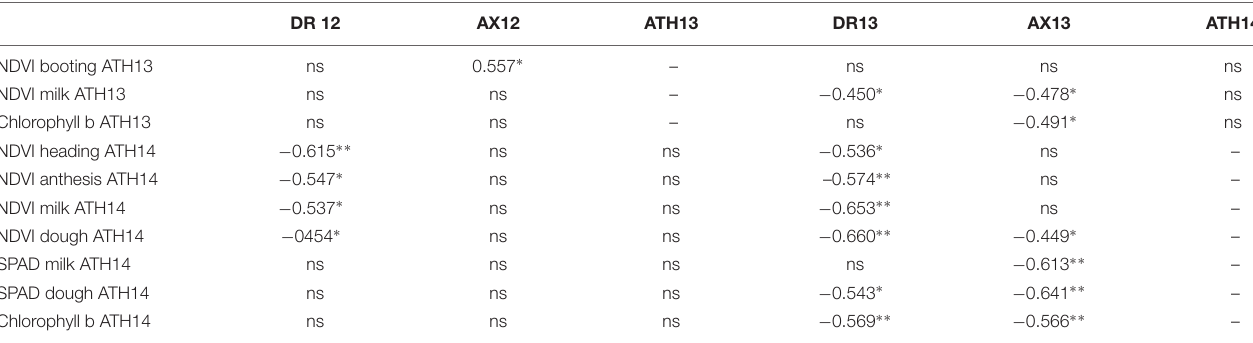
TABLE 7 | Pearson correlations between NDVI at different stages, SPAD at milk and dough stages and chlorophyll b with grain yield from the same set of genotypes grown at different years and locations (DR12, Dromolaxia 2011/12; AX12, Achelia 2011/12; ATH13, Athalassa 2012/2013; DR13, Dromolaxia 2012/13; AX13, Achelia 2012/13; ATH14, Athalassa 2013/2014).